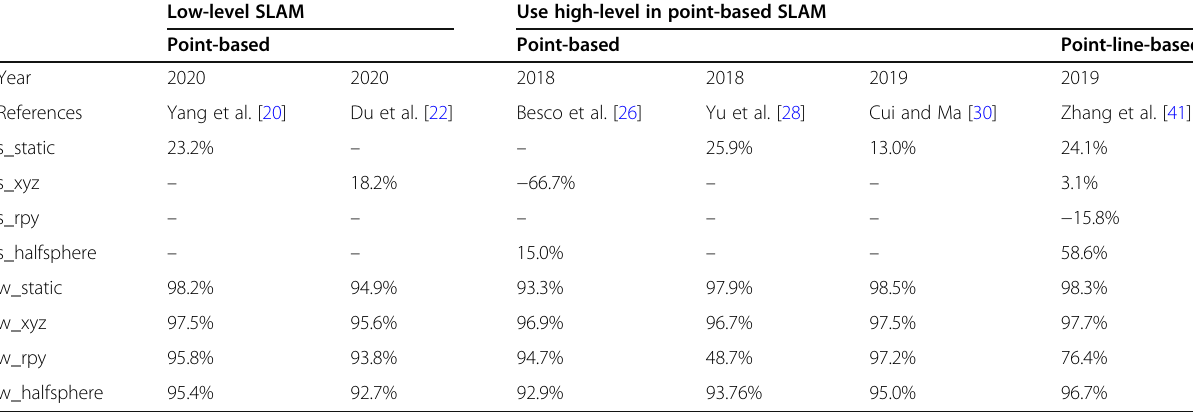
Table 4 Root-mean-squared error of ATE improvement for robust SLAM compared to ORB-SLAM2 on TUM